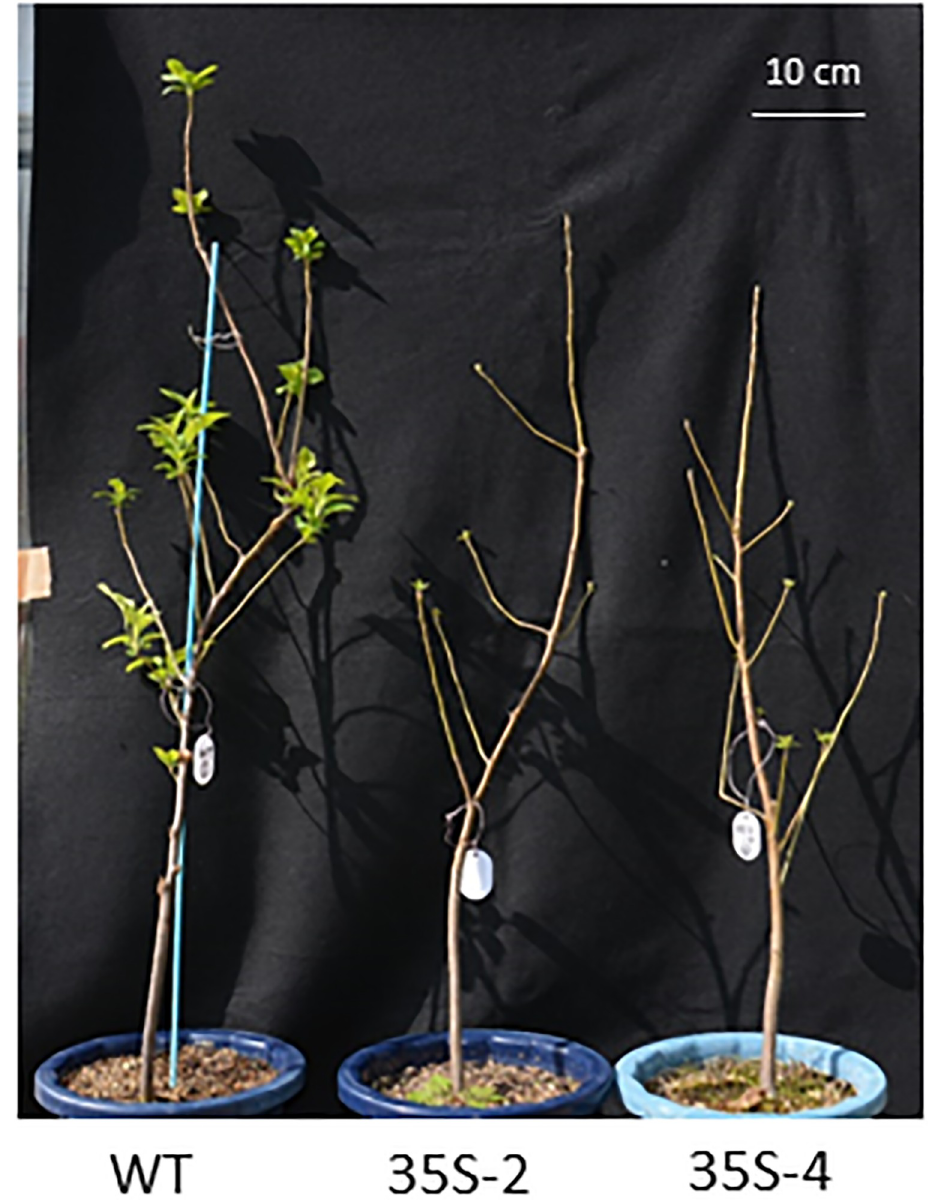
Fig 4. Terminal bud break in the spring was delayed in 5-year-old 35S : PmDAM6 apple plants. Photograph taken on 15 April 2016. Plants were grown in a greenhouse without heating, resulting in an exposure to naturally occurring cold conditions in the